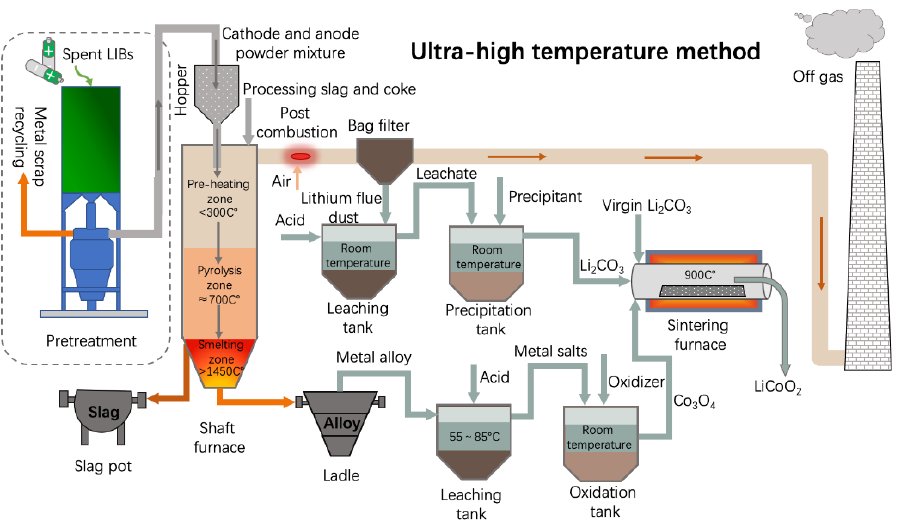
Figure 1. Schematic of the Ultra-high treatment method of spent LIB recycling system.